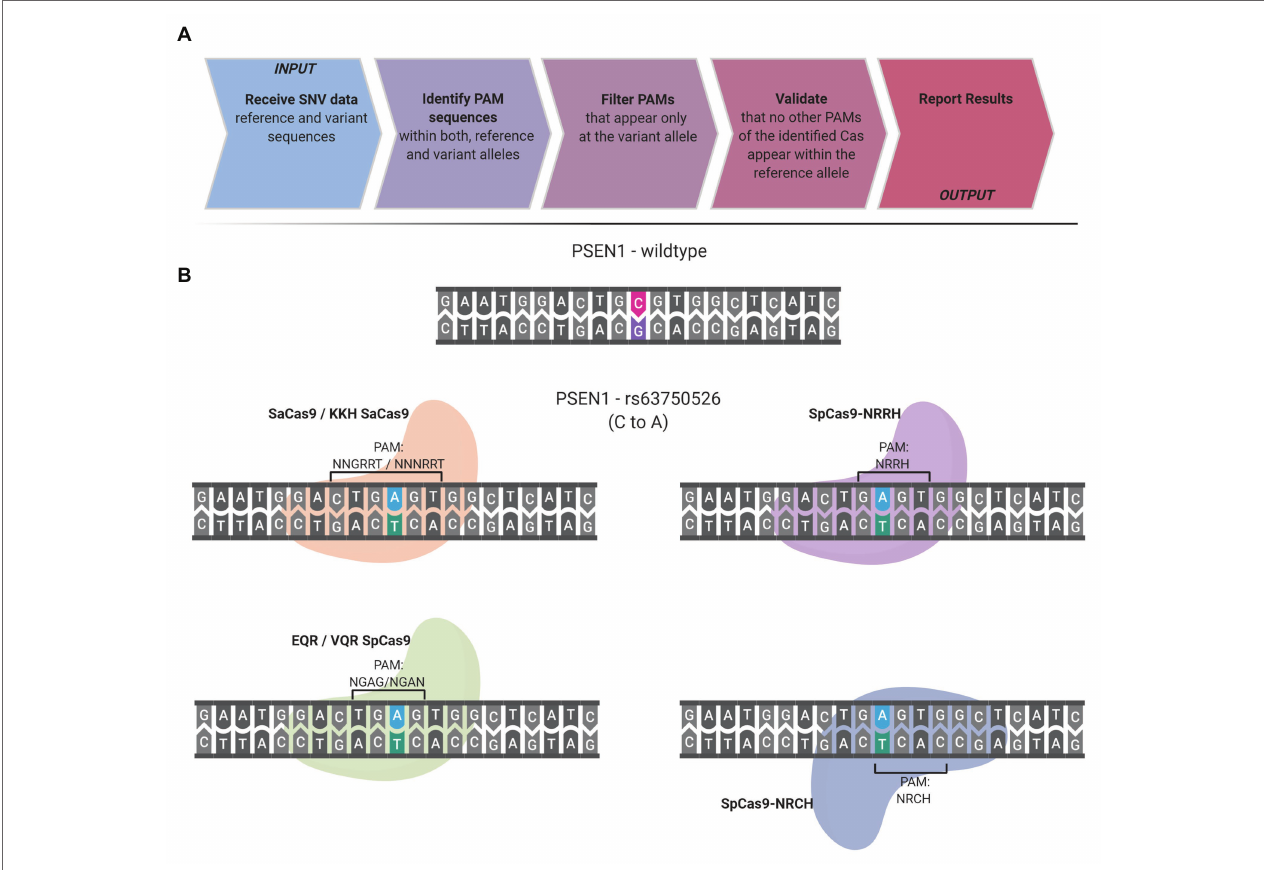
FIGURE 1 | CrisPam workflow and single-nucleotide polymorphism (SNP)-derived protospacer adjacent motif (PAM) case study. (A) CrisPam’s analysis pipeline. (B) A case study: the rs63750526 SNP of the PSEN1 gene, known as a risk factor for early onset Alzheimer’s disease, as an example of multiple PAMs generated by a SNP. The base substitution (C to A) generates the PAM sequences of six Cas variants (SaCas9, KKH SaCas9, EQR Cas9, VQR Cas9, SpCas9-NRRH, and